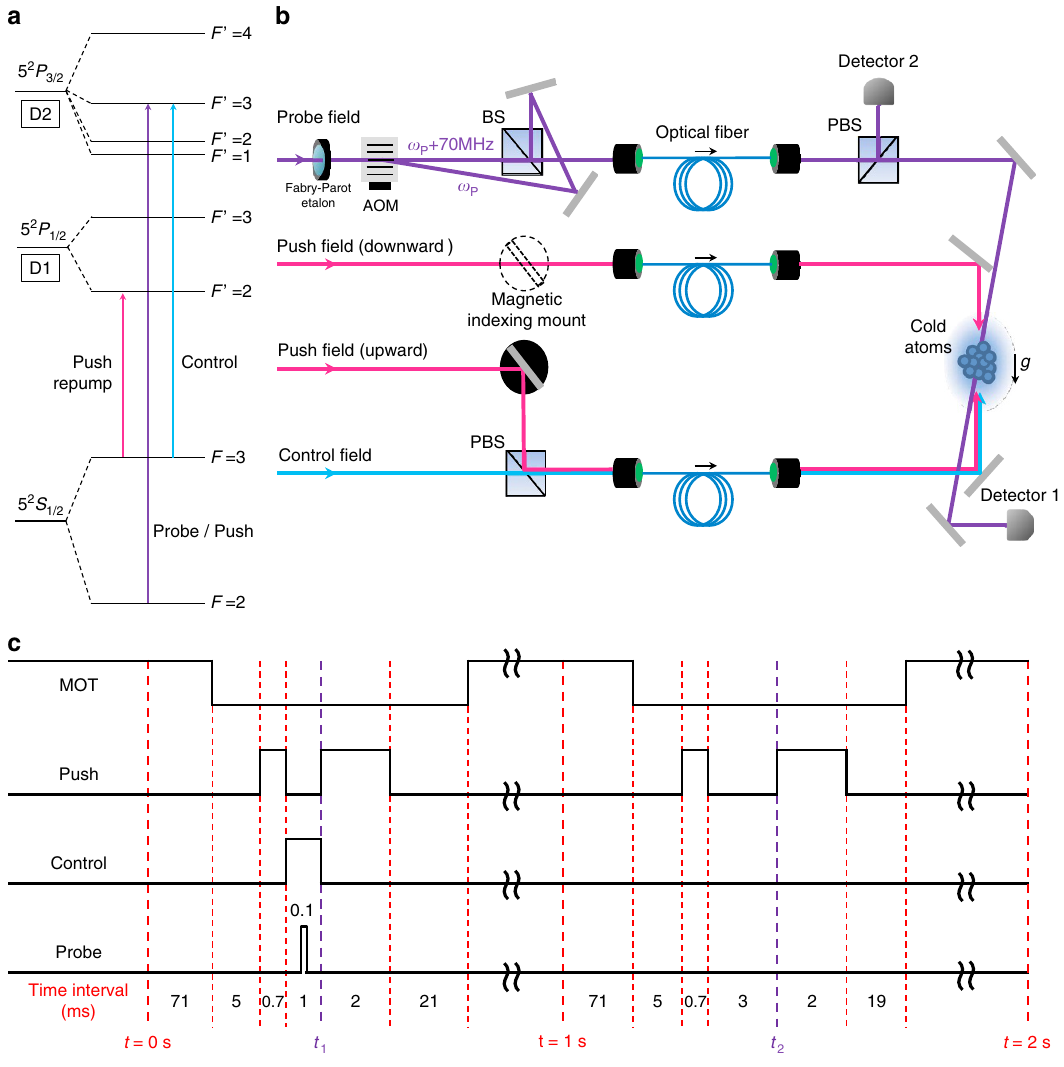
Figure 1 | Experimental details. ( a ) Level diagram of relevant atomic transitions for the experiment. ( b ) Experimental set-up: BS is a beam splitter. PBS is a polarizing beam splitter. AOM is an acoustic-optical modulator. We use a magnetic indexing mount to switch between pushing atoms upward and downward. In the pushing upward set-up, the push field is overlapped with the control field and coupled to a single mode fiber. In the push downward case, the push field is coupled backward to the control field fiber exiting port with 75% coupling efficiency to ensure the overlap of the control and push field. Detector 2 records the reference field for comparing the phase of the probe field from detector 1 on an oscilloscope. The local gravity g is pointing downward. The probe field frequency is o p . The probe and control fields are aligned around 183 (cid:2) . ( c ) Timing sequence of the experiment. Magneto-optical trap (MOT) represents the timing sequence for cooling and repumping fields as well as the magnetic field for the preparation of the cold atomic ensemble. The push field is on at t ¼ t 1 and t ¼ t 2 for the determination of the velocity by imaging the position of the atomic cloud 1 and 3ms after the push